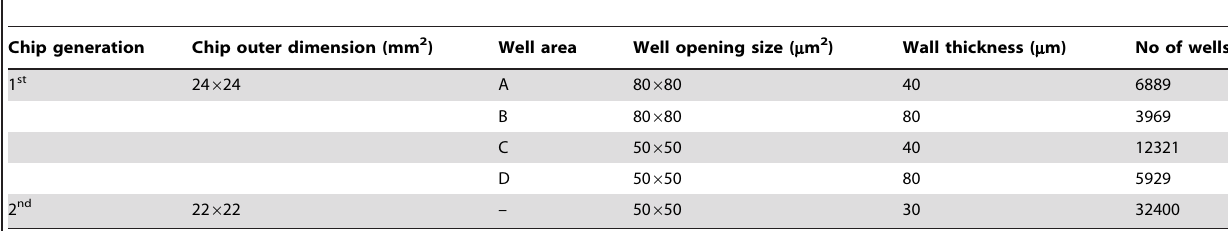
Table 1. Dimensions of first and second generation of